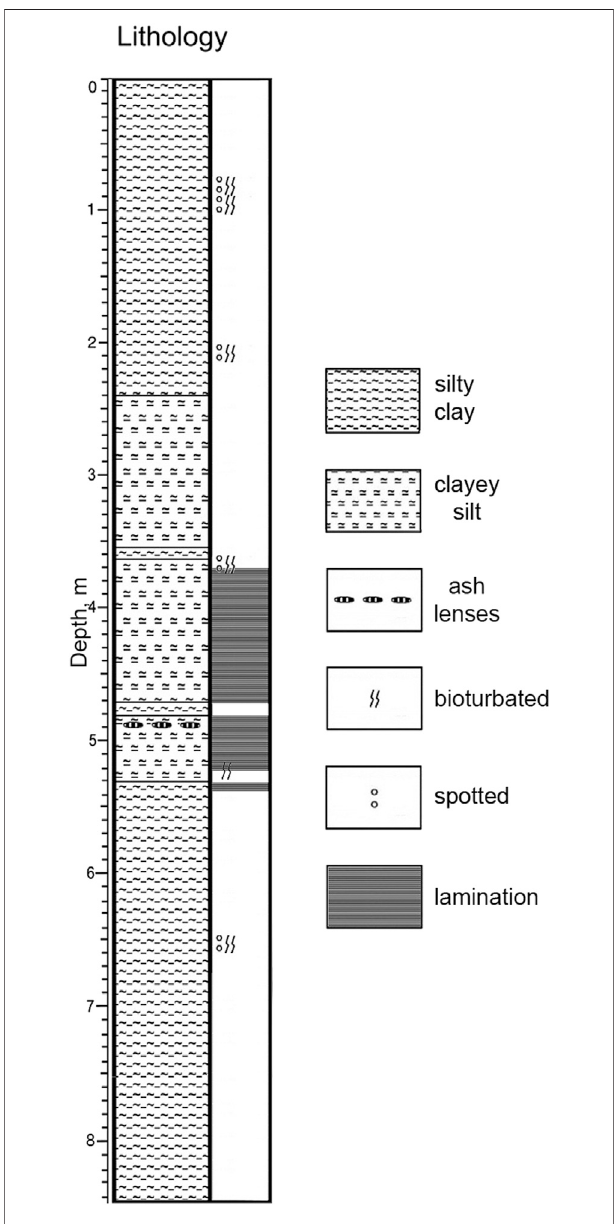
FIGURE 2 | Lithology of sediment core